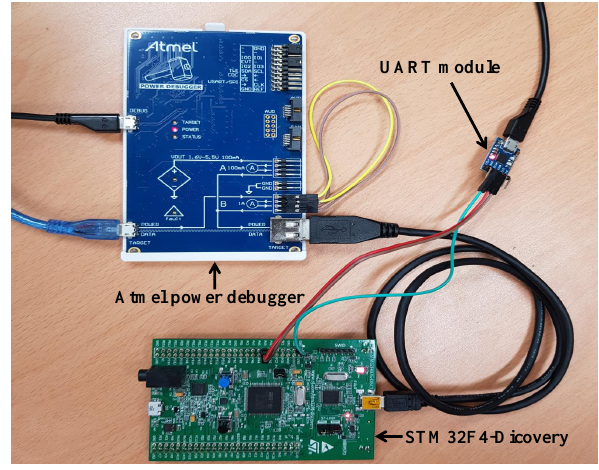
Figure 8. Experiment configuration. The Amtel power debugger and the UART modules are used to measure the operating cycle and current dissipation in the MCU,